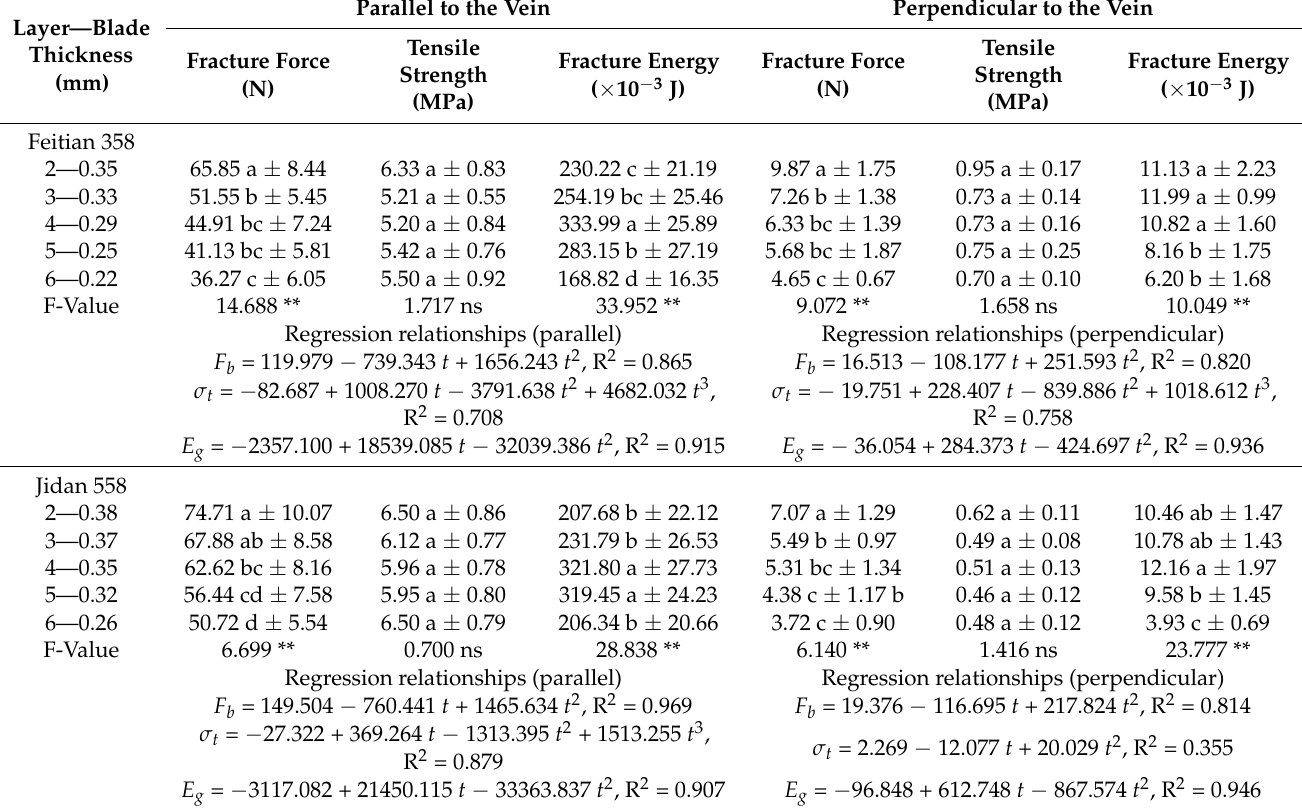
Table 4. Tensile properties of the second to sixth leaf blades (mean ± SD) and repeated measures analysis of variance.